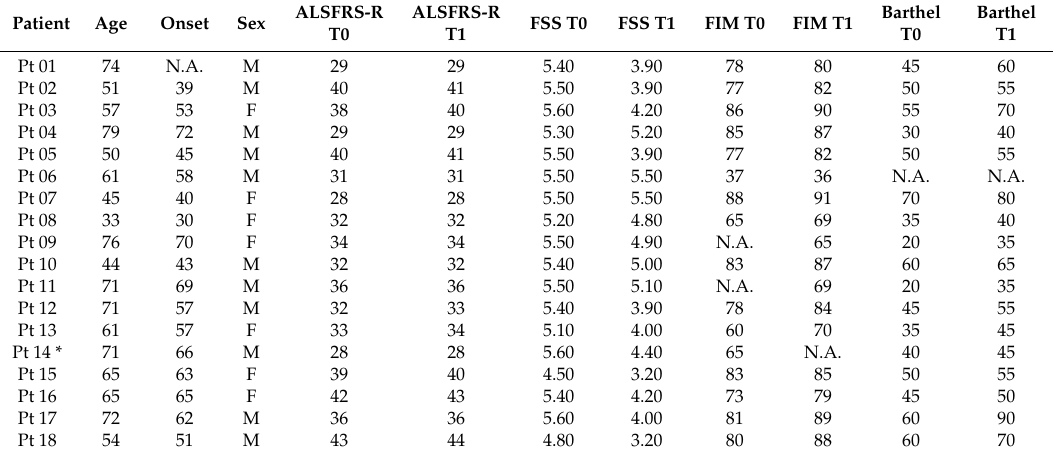
Clinical features and disability scales of ALS patients before (T0) and after (T1) rehabilitation